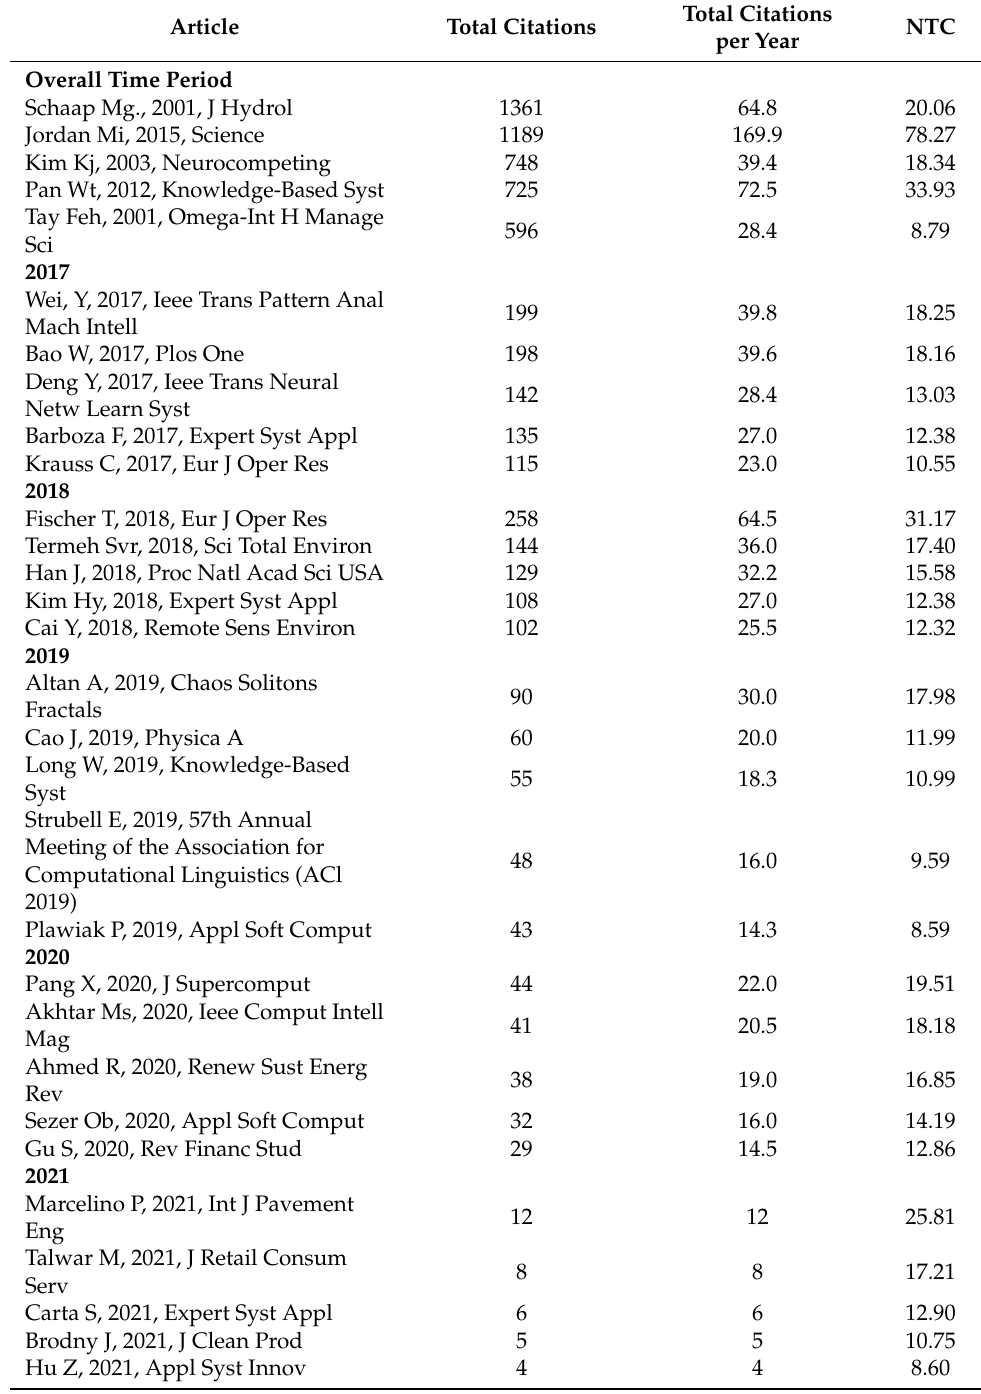
Table 7 illustrates the citations of the articles in our sample. Table 7. Most cited manuscripts, overall period, and per